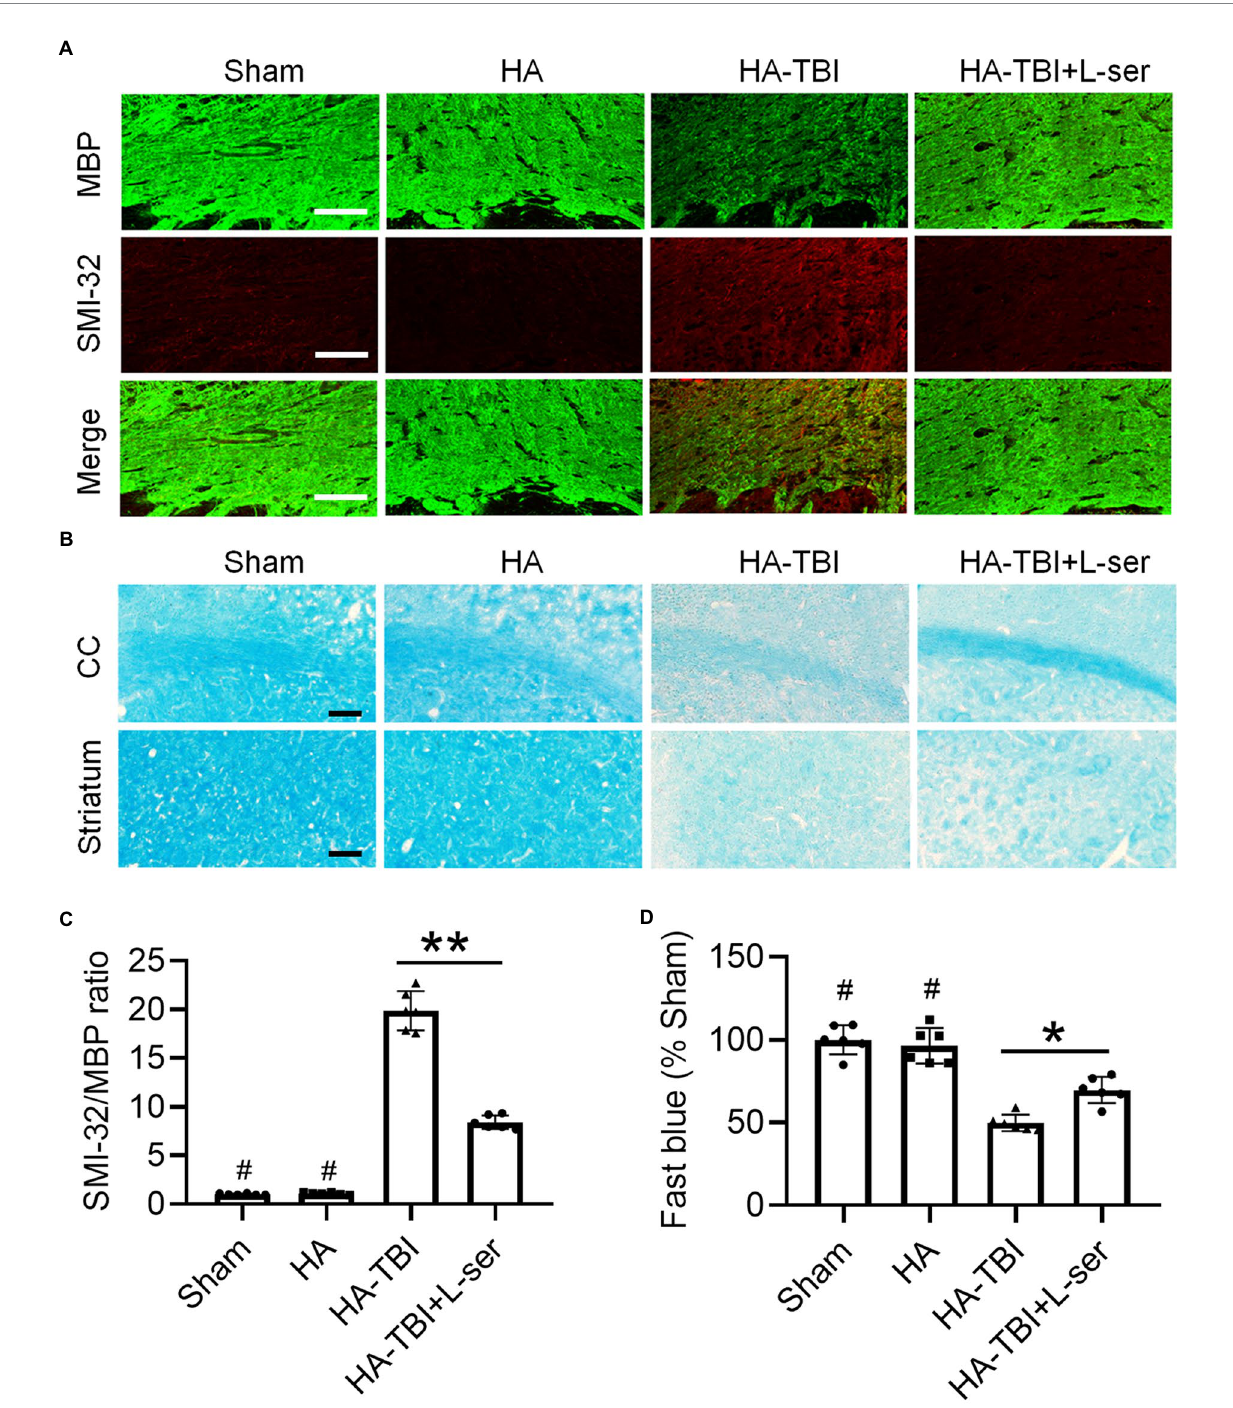
FIGURE 4 Effects of L-serine against white matter injury in mice after HA-TBI. (A) Double immunofluorescent staining for SMI-32 and MBP in the right CC in different groups. (B) Representative fast blue staining of the CC and striatum, scale = 50 μ m. (C) Relative quantification of the ratio of SMI-32 to MBP ( n = 6). (D) Quantification of Luxol fast blue staining normalized to sham animals ( n = 6). * p < 0.05, ** p < 0.01 versus the indicated group; # p < 0.01 versus other